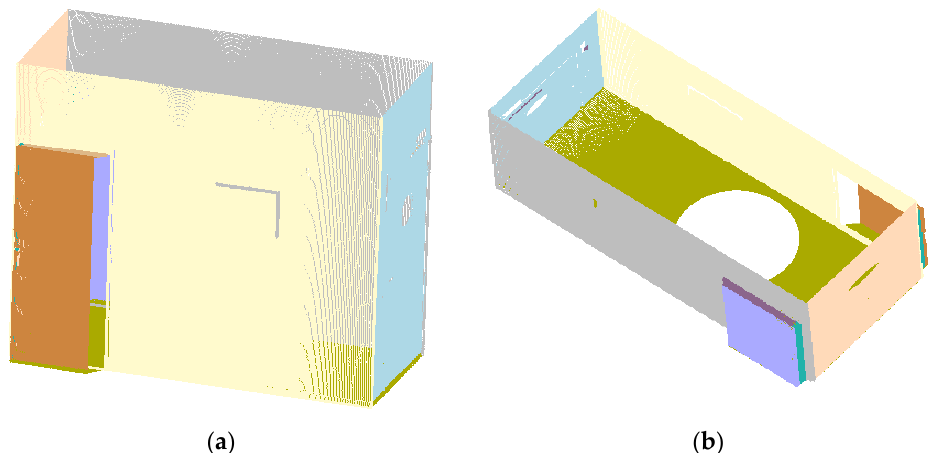
Figure 9. Cottage’s segmentation results using the RANSAC algorithm: ( a ) front view and ( b ) top view.